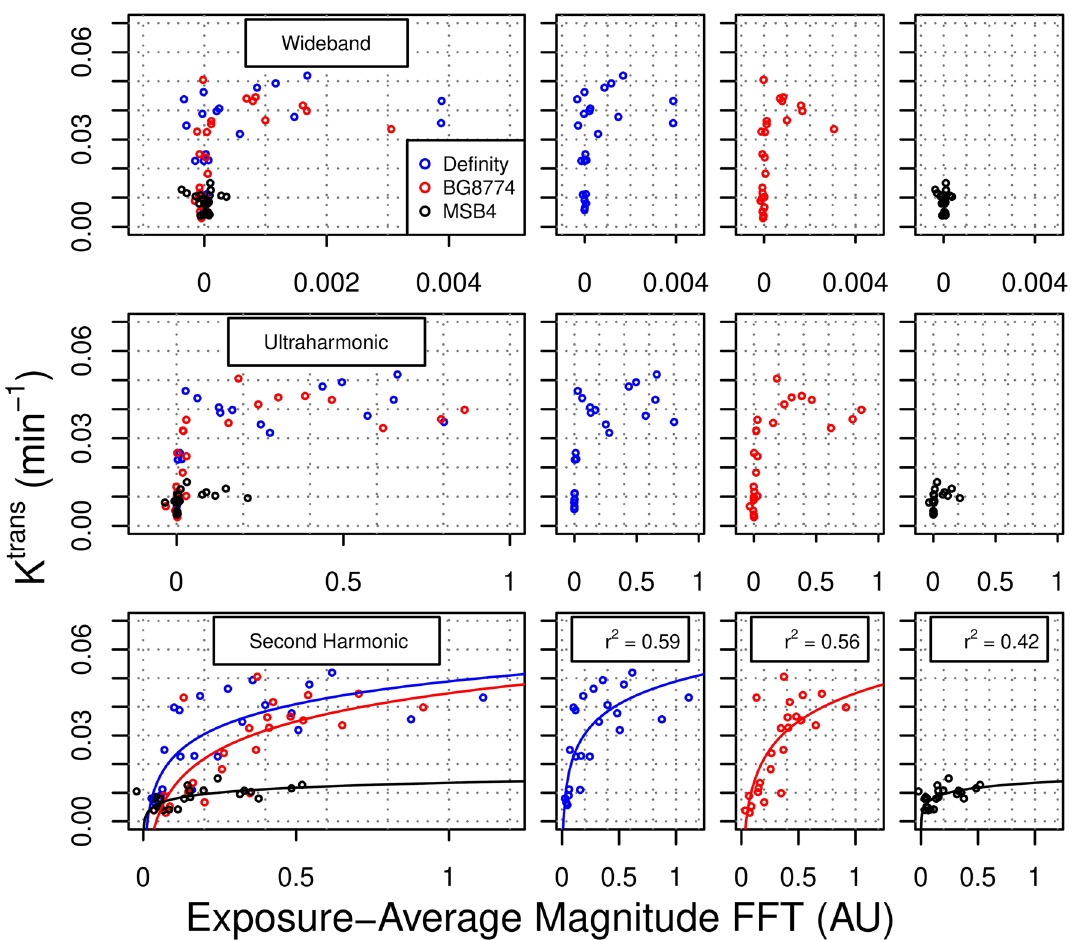
Figure 6. Relationship between acoustic emissions and K trans . Animals in cohort #3 were sonicated at a range of fixed peak negative pressures. Dynamic contrast-enhanced magnetic resonance imaging was used to quantitatively assess blood–brain barrier permeability to gadobutrol (K trans ). Exposure-average magnitudes of ultraharmonic and wideband emissions for both Definity and BG8774 were negligible at targets displaying K trans below 0.03 min −1 . All microbubble formulations exhibited a semi-log relationship between exposure-average magnitudes of 2 f emissions and K trans , with adjusted r 2 values of 0.59, 0.56, and 0.42, for Definity, BG8774, and MSB4, respectively. AU arbitrary units, FFT fast Fourier transform.